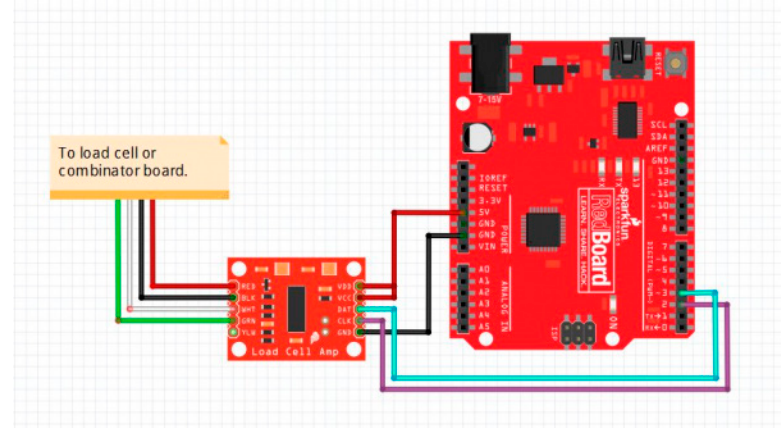
Figure 2. HX711 loadcell wiring diagram, courtesy of sparkfun.com.